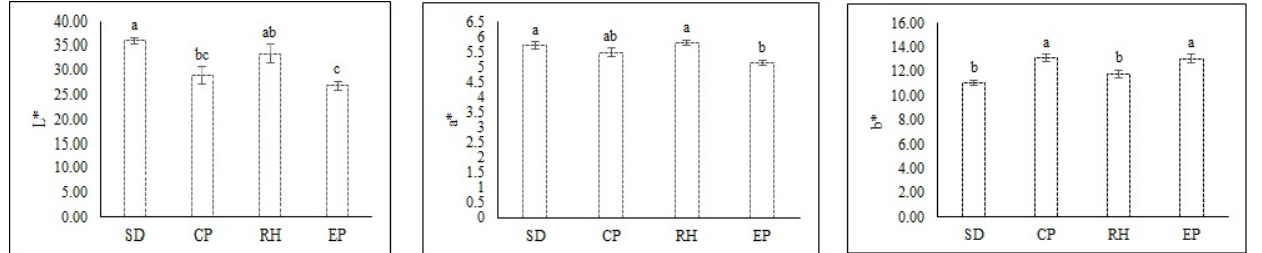
Figure 5. Lightness (L*), green–red chromaticity (a*), and blue–yellow chromaticity (b*) of lettuce leaf under different